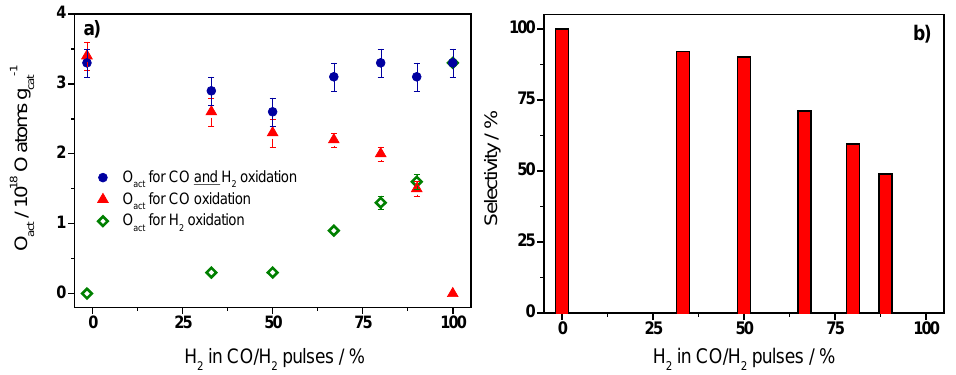
Figure 2. ( a ) Absolute amounts of active oxygen (O act ) removal from a fully oxidized Au/TiO 2 catalyst (after O 2 /Ar pulses) by CO and/or H 2 during CO, H 2 , and CO/H 2 pulses with varying ratios of H 2 (33%–89% H 2 ) at 80 °C, and ( b ) corresponding selectivities for CO oxidation/CO 2 formation during the CO/H 2 /Ar pulses at 80 °C.